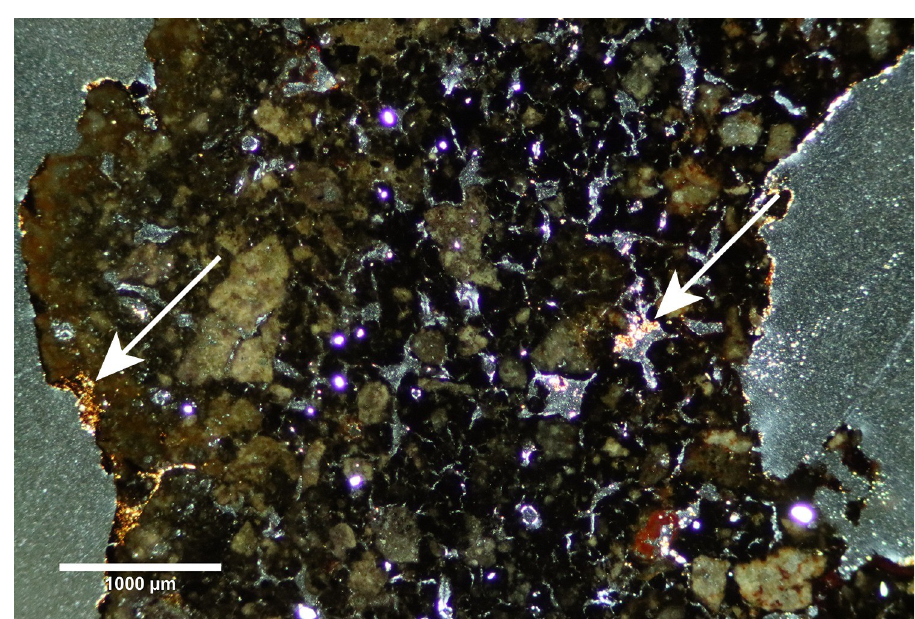
Fig 6. Photomicrograph of Mayapa´n tuy è re paste. Photomicrograph in cross polarized light of M-55 with small amounts microcrystalline calcite (indicated by arrows) deposited along the exterior surface and in a few pores, interpreted as the result of post-depositional groundwater. The bright white crystalline inclusions are small pieces of quartz. Color variability suggest differential vitrification and highlights potential pieces of grog. Photomicrograph by Jennifer Meanwell.